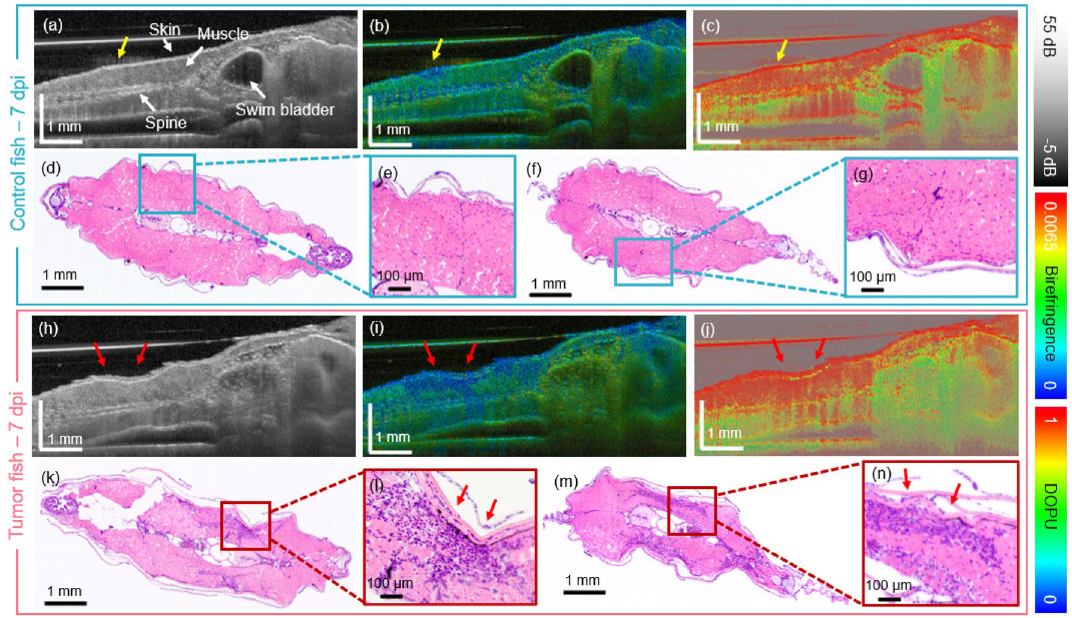
Figure 1. The OCT in comparison to histology results for the first generation of xenograft zebrafish at 7 days post-injection (dpi). ( a – c ) Scatter intensity, birefringence and DOPU sagittal cross-section images in a PBS injected control fish. The injection site is indicated by yellow arrows. ( d – g ) Corresponding transverse H &E-stained histology micrographs. ( h – j ) Scatter intensity, birefringence, and DOPU sagittal cross-section images in a tumor injected zebrafish. ( k – n ) Corresponding transverse H &E-stained histology images. The tumor location is indicated by red